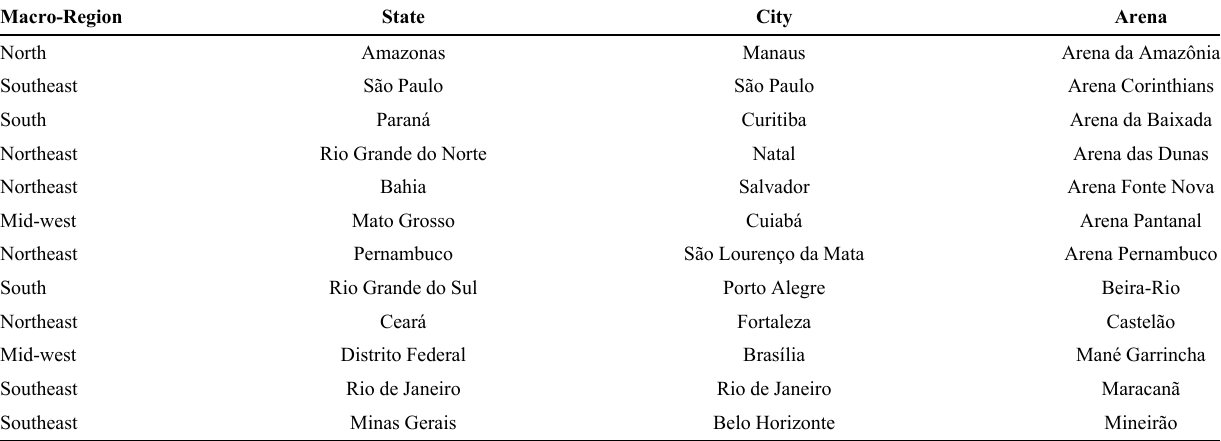
Table 1 - Brazil 2014 FIFAWorld Cup ™ Arenas. Macro-Region